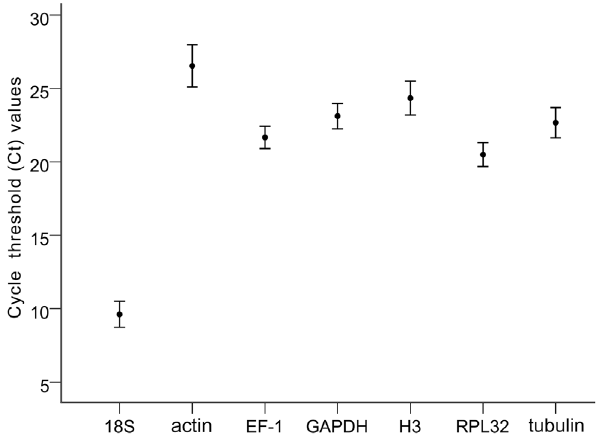
Figure 1. Expression levels of candidate reference genes in different samples. The black dot indicates the mean of duplicate samples, and the bars indicate the standard deviation of the mean.